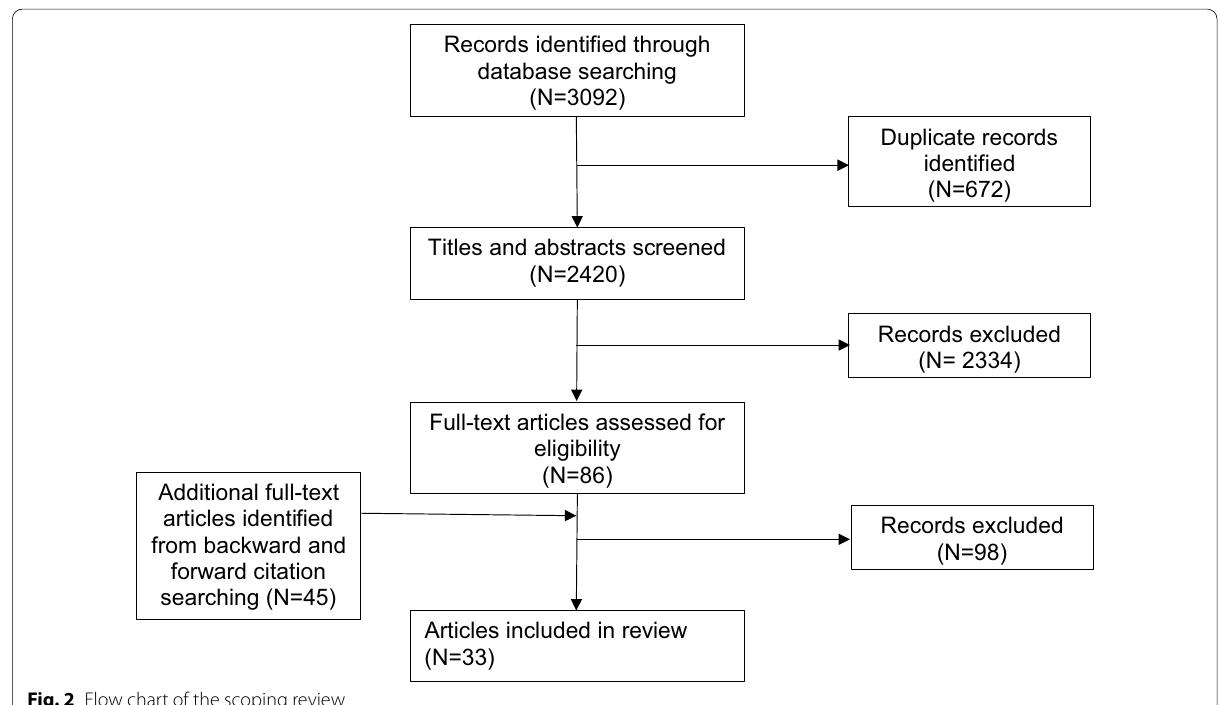
Fig. 2 Flow chart of the scoping